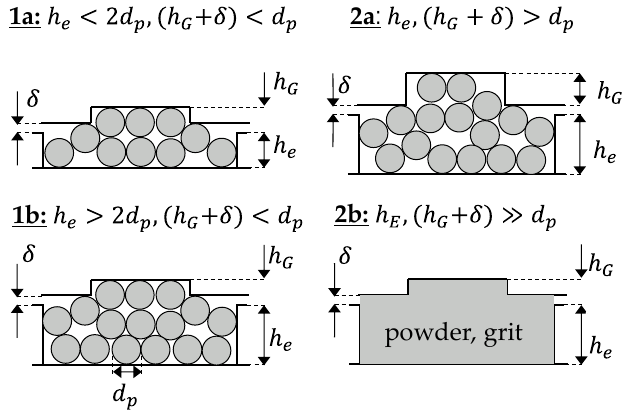
Figure 11. Adjustment of the definition of the conveying cases by the screw clearance 𝛿 .